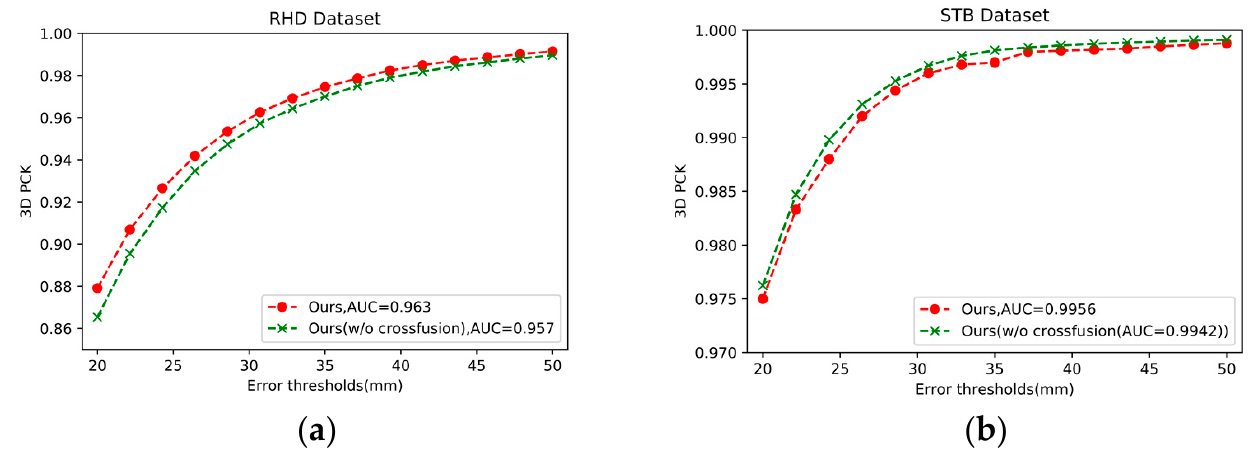
Figure 4. Ablation study for the training data on the RHD ( left ) and STB ( right ). ( a ) Describes the effectiveness of RGB image and depth map input in the RHD. ( b ) Describes the effectiveness of RGB image and depth map input in the STB.